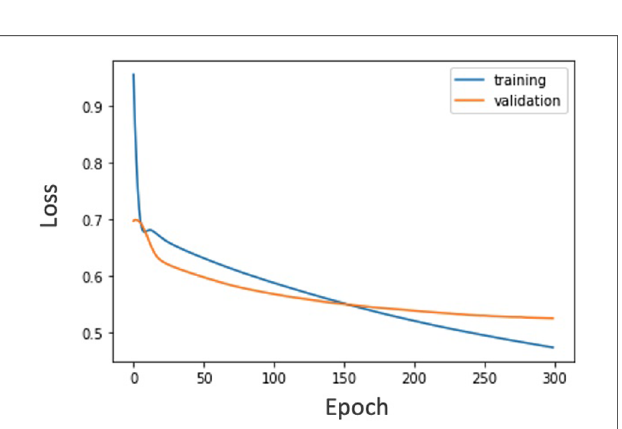
FIGURE 6 Loss during training of the CNN in the Sz and control group classi fi